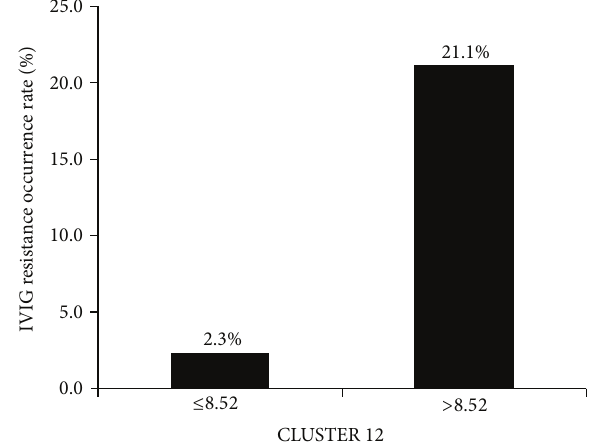
Figure 2: Rate of intravenous immunoglobulin resistance in patients with Kawasaki disease by plasma CLUSTER 12 concentra- tion ( ≤ 8.52 or > 8.52